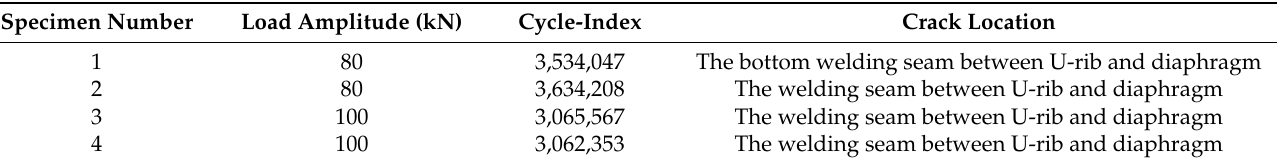
Table 4. Fatigue test results.